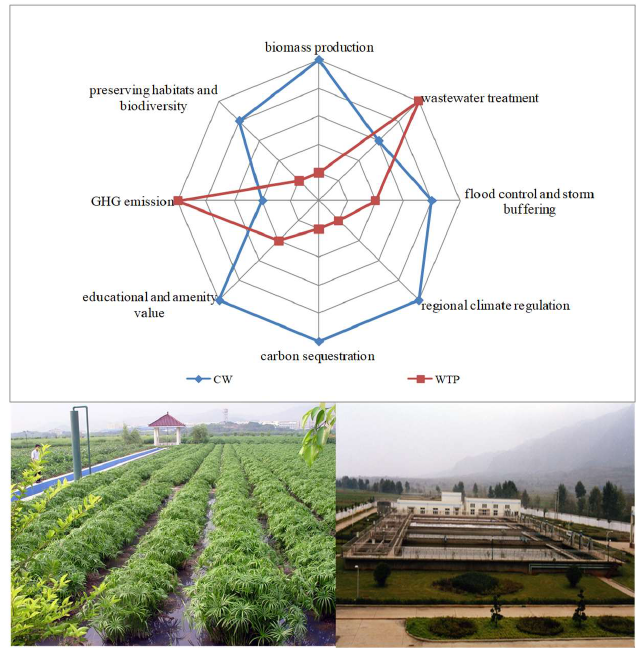
Figure 4. Conceptual frameworks comparing ecosystem services of a CW (blue line, left picture) and a WTP (wastewater treatment plant) (red line, right picture). The condition of each service in the diagrams is indicated along each ‘petal’ to illustrate the provisioning of multiple ecosystem services under different land use regimes. The value for radiation point of each ecosystem service is increased from the inside to the outside.